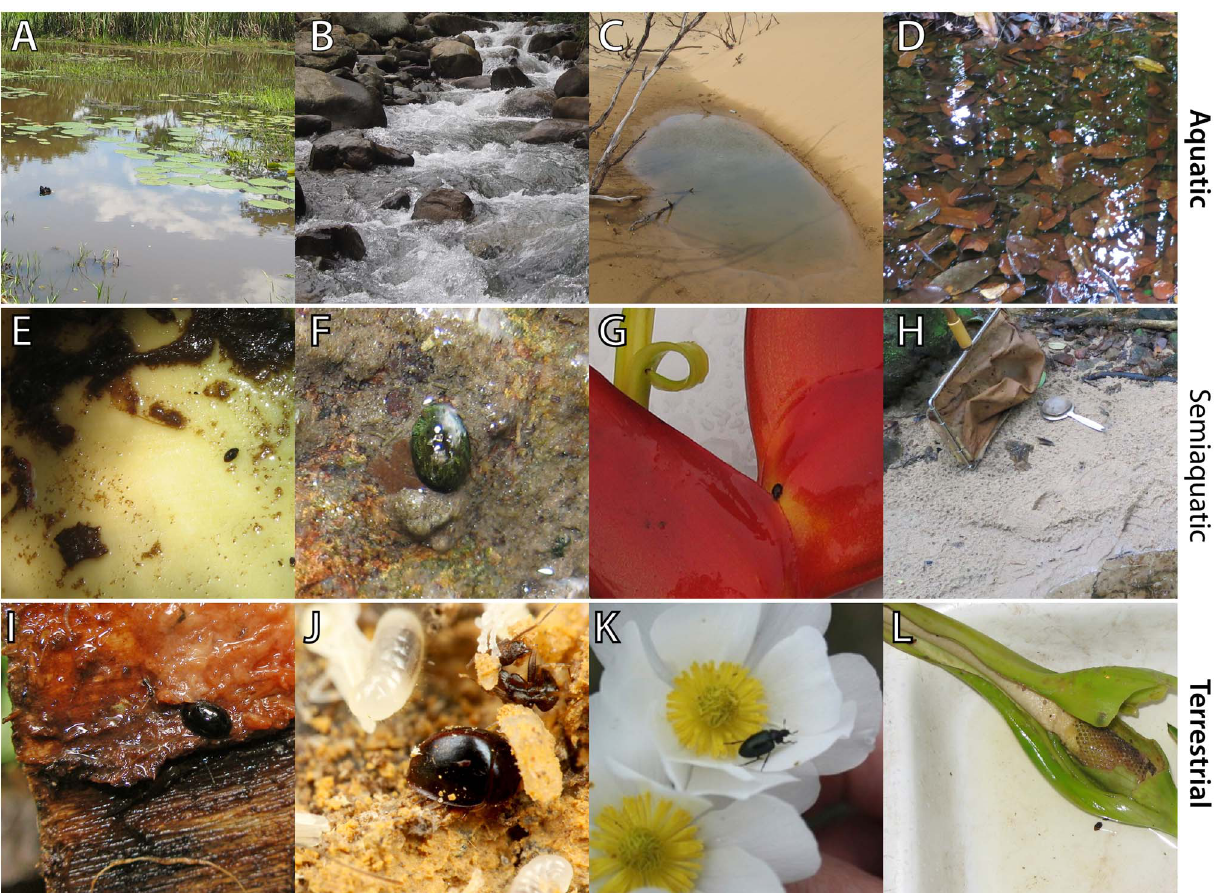
Figure 2. A selection of habitat diversity within the Hydrophilidae. A) Lentic habitat in a vegetated marsh, B) Lotic habitat along a mountain stream, C) Coastal dune pond, D) Detrital forest pool, E) Anacaena sp. (Chaetarthriinae) inside a drained bromeliad tank, F) Oocyclus sp. (Laccobiini: Laccobius group) on a wall seepage, G) Pelosoma sp. (Megasternini) emerging from a Heliconia inflorescence, H) wet sand habitat along a creek, I) Dactylosternum sp. (Coelostomatini) under the bark of a freshly cut tree, J) Chimaearocyon shimadai (Megasternini) in the brood chamber of Pheidole ants, photo credit: Taku Shimada, K) Rygmodus sp. (Rygmodinae) on flowers, photo credit Richard Leschen, L) Nitidulodes sp. (Megasternini) on an aroid inflorescence. All photos by A.E.Z. Short unless otherwise indicated.